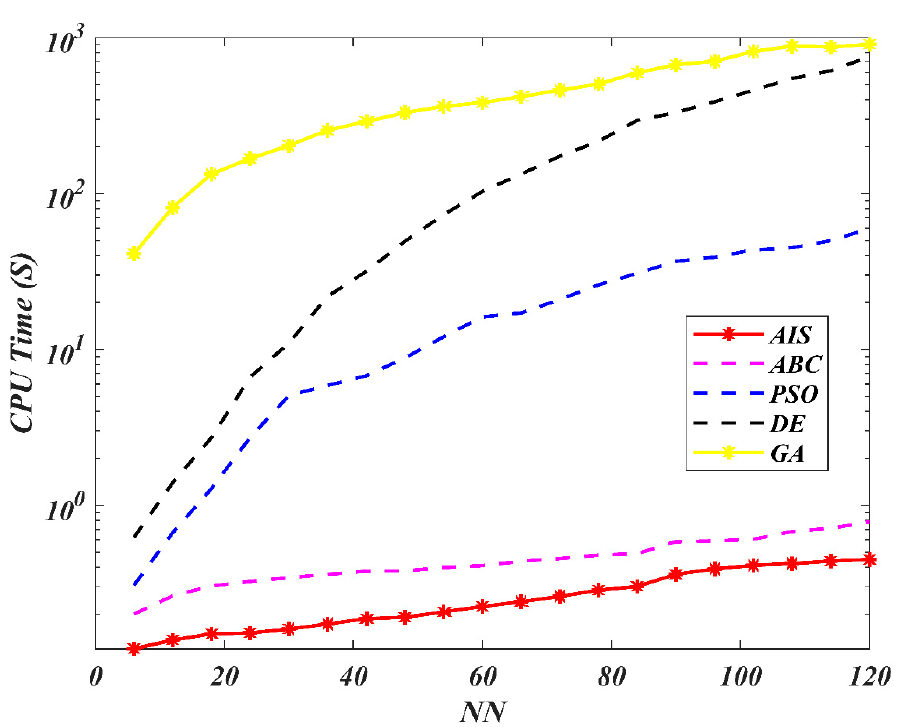
Figure 27. CPU time Evaluation for Postoperative Patient.